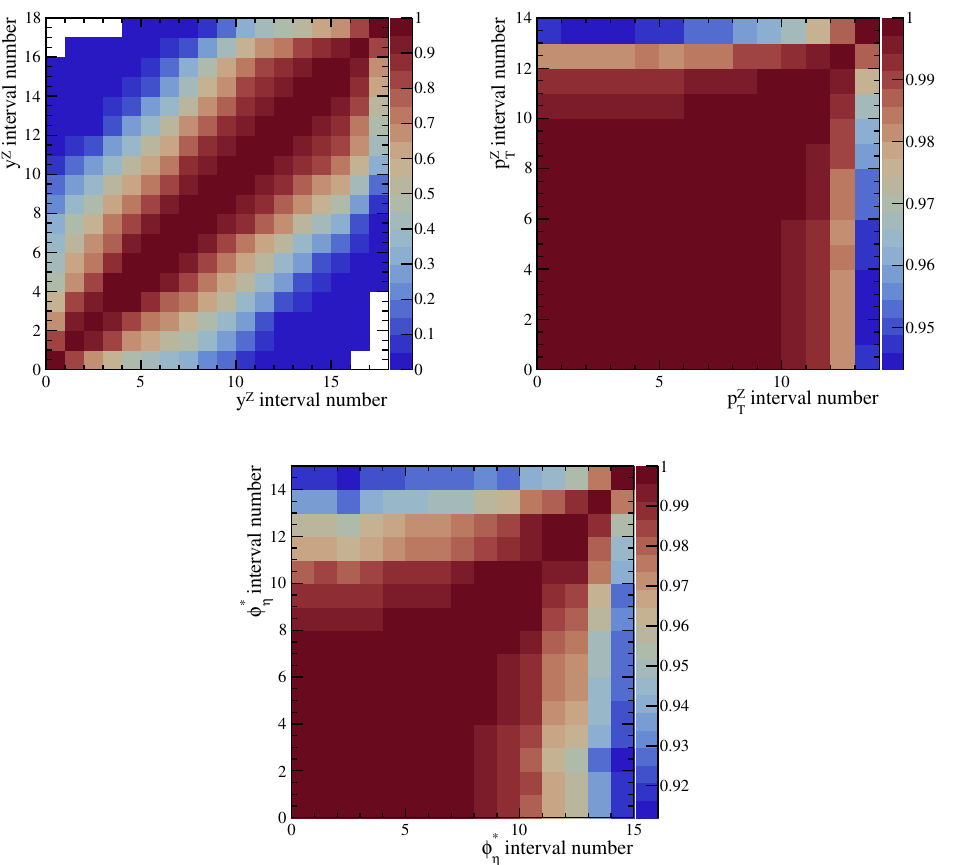
Figure 14 . Correlation matrix of efficiencies uncertainty for one-dimensional (top-left) y Z , (top- right) p Z and (bottom) φ ∗ measurements. More details about the ‘interval number’ can be found η T in table 14 and table 16.